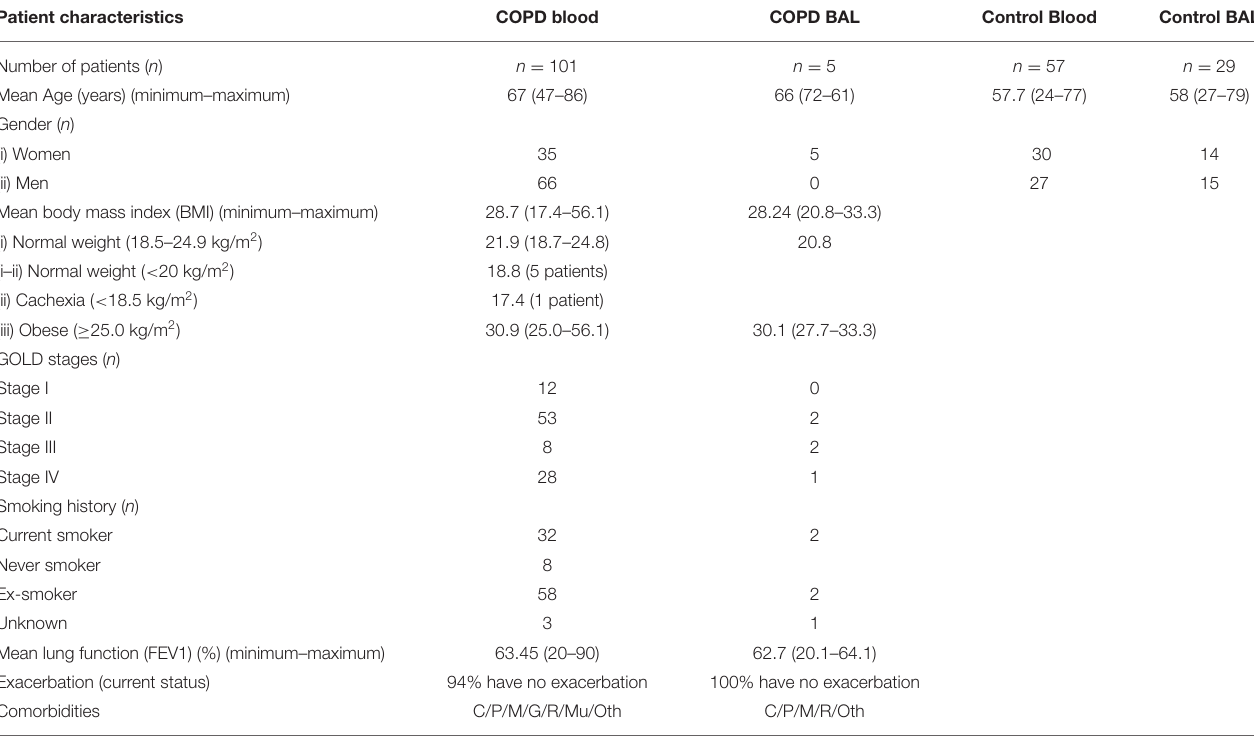
TABLE 1 | Basic characteristics of COPD patients and controls. Patient characteristics